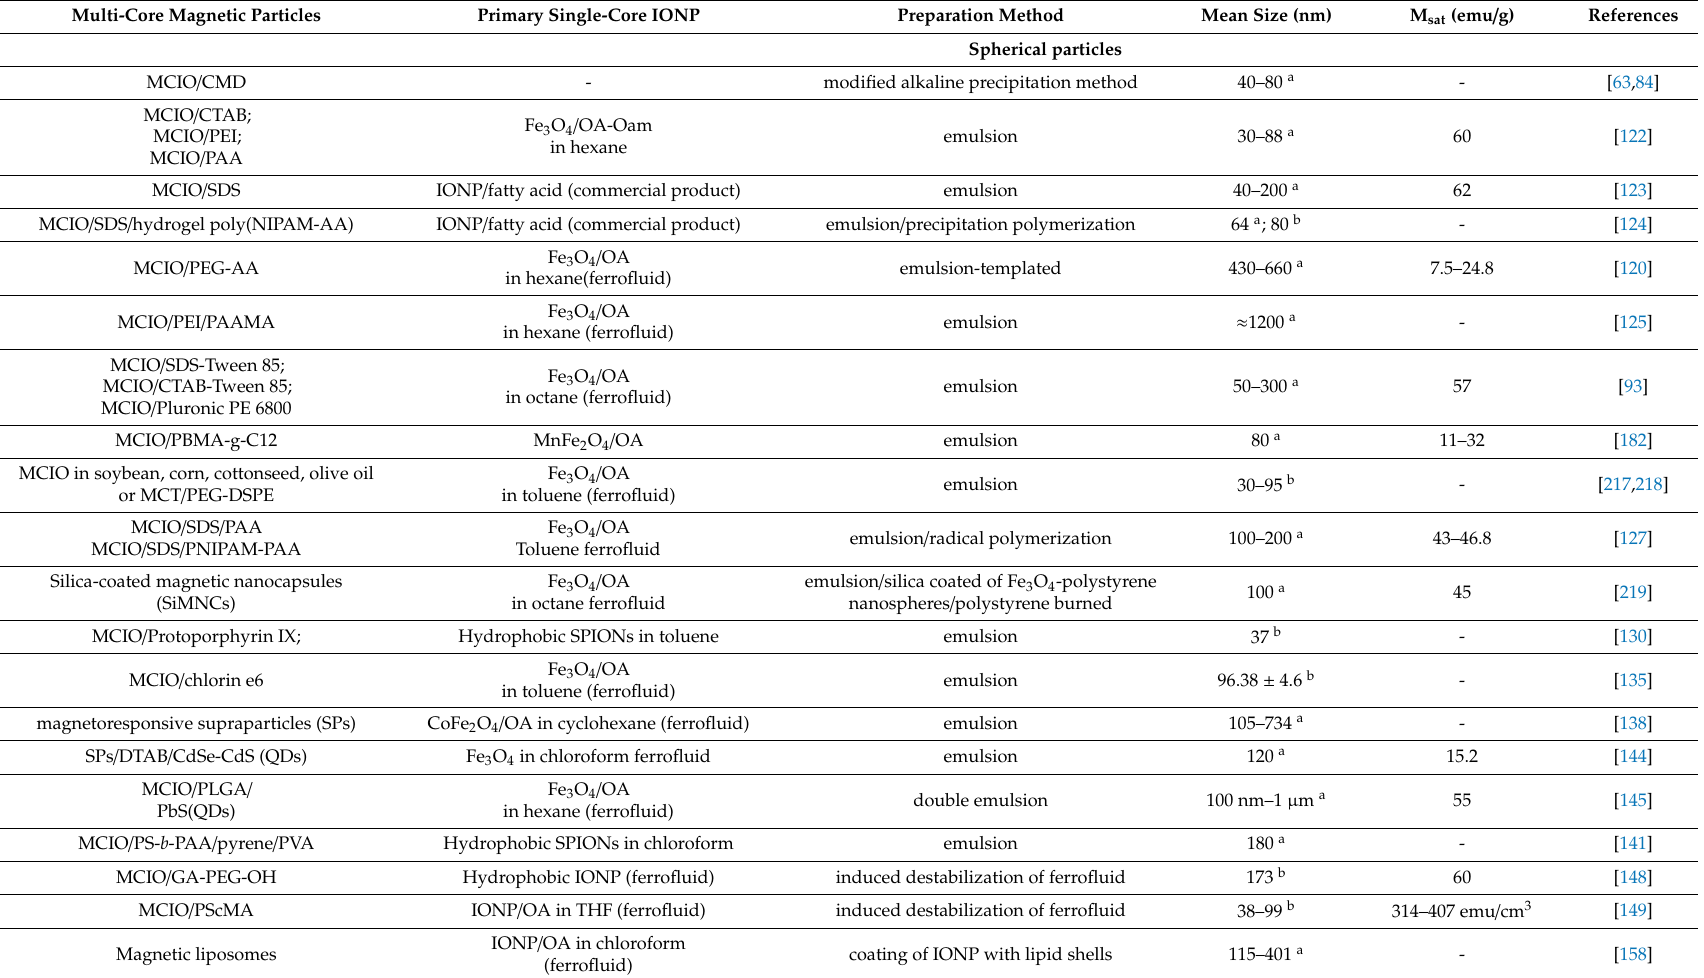
Table 1. Spherical and non-spherical multi-core magnetic